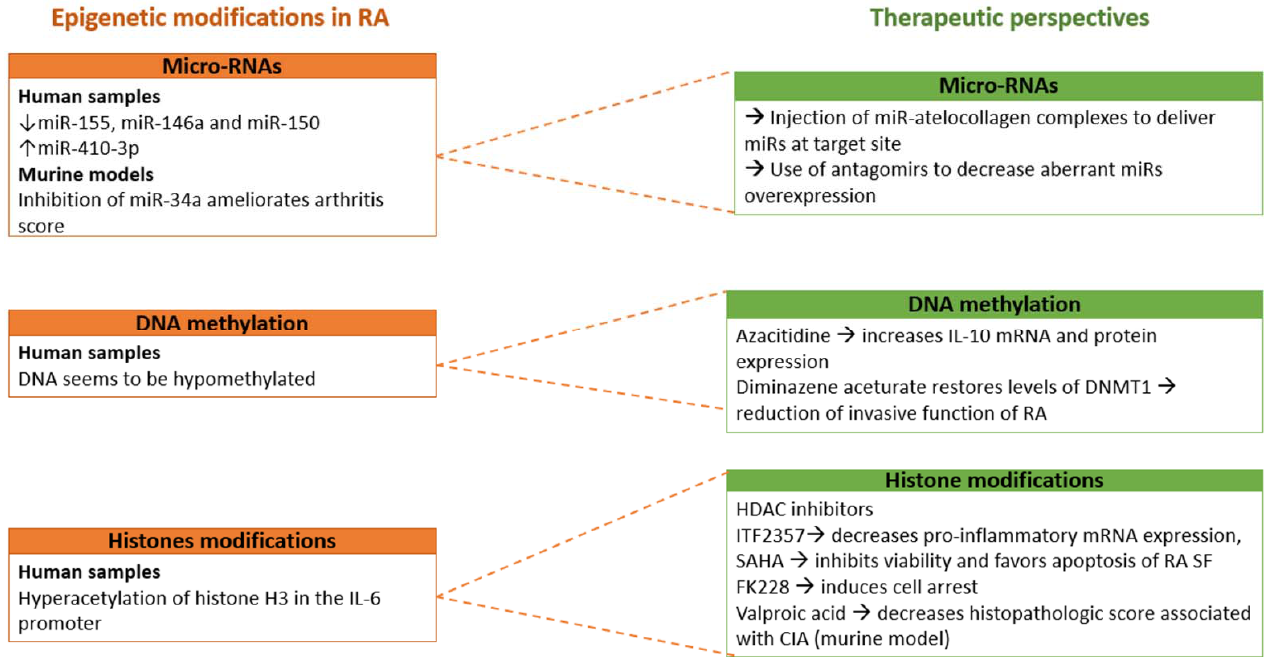
Figure 10. Conclusion scheme.